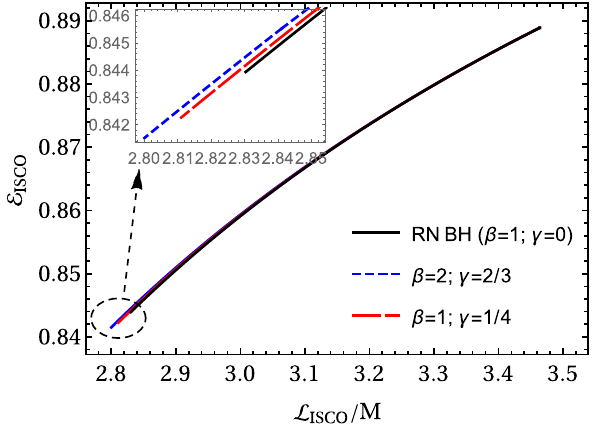
Fig. 9 The energy efficiency as a function of the BH charge Q for different values of EMS parameters β and